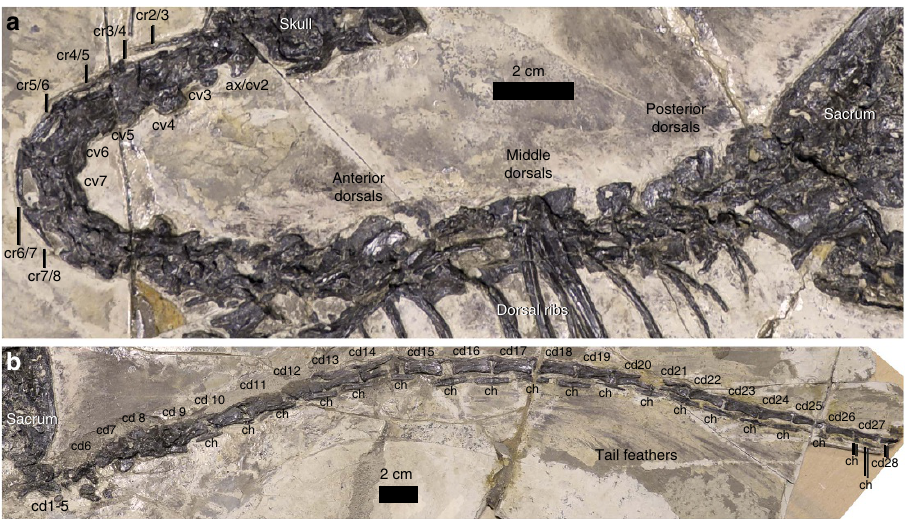
Figure 3 | Vertebral column of Jianianhualong tengi holotype DLXH 1218. ( a ) Presacral vertebrae. ( b ) Caudal vertebrae. Scale bar, 2cm. ax, axis; cd, caudal vertebra; ch, chevron; cr, cervical rib; cv, cervical